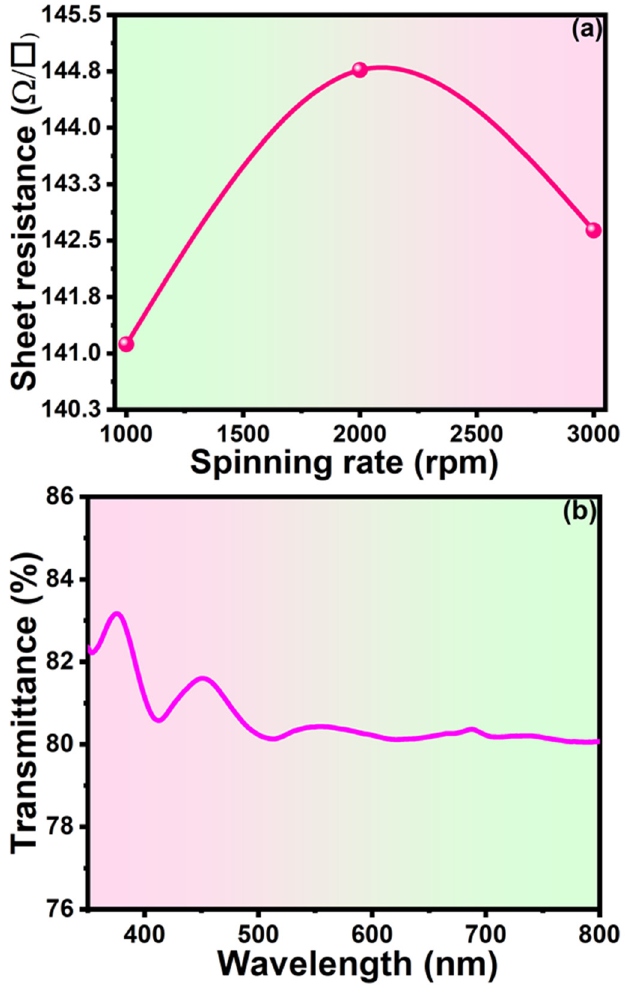
Figure 7. Analysis of ( a ) Sheet resistance ( b ) Transmittance of HfO 2 ARC layer-based c-Si solar cell.